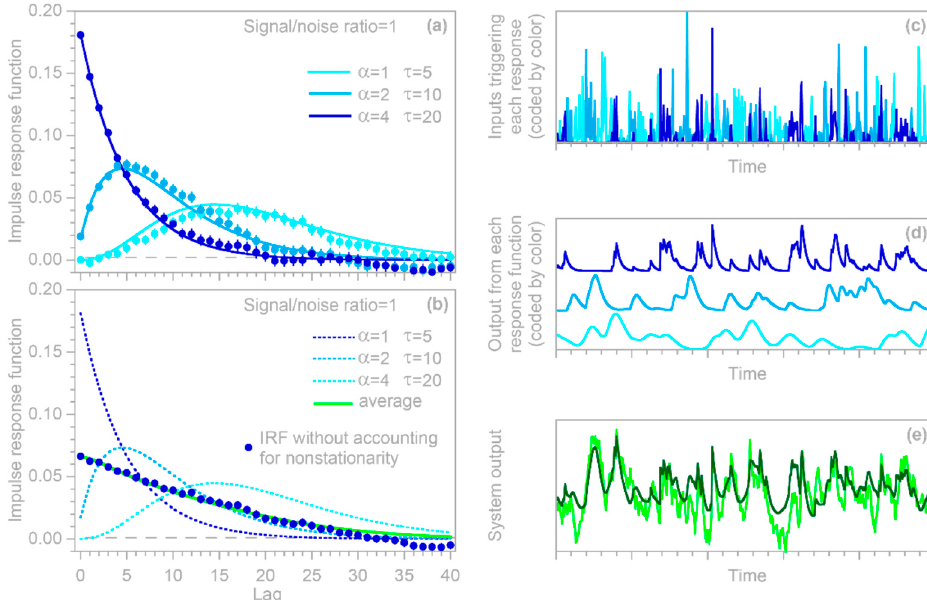
Figure 6. Benchmark test with a nonstationary system that randomly shifts between three different impulse response functions. The three impulse responses are shown by the light, medium, and dark blue curves in ( a , b ), and are triggered by the correspondingly colored inputs in ( c ), yielding the output components in ( d ). These output components are not individually identifiable, but instead combine to form the system output in ( e ), shown with (light green) and without (dark green) added ARMA noise. The true system output (dark green) in ( e ) and its individual components in ( d ) are unobservable in practice. The estimated impulse response functions shown by the solid circles in ( a ) are inferred from the input in ( c ) and the ARMA-noise-corrupted output signal (light green) in ( e ) using the IRF routine. If one treats the system as if it is stationary (by ignoring the differences among the colored input times in ( c ), the IRF routine yields the solid circles shown in ( b ), which correspond closely to the ensemble average (light green curve) of the three impulse responses (dashed curves). Values of α and τ in ( a , b ) are parameters of the gamma distributions used for the benchmark impulse responses. Noise in ( e ) is ARMA(1,2), with an AR coefficient of 0.9 and MA coefficients of − 0.2 and +0.2, added to the true system output at a signal-to-noise ratio of 1. Error bars in ( a , b ) indicate 1 standard error, and lines in ( d ) are shifted vertically for clearer visualization. Panels ( c – e ) show 500 time steps, equaling five percent of each time